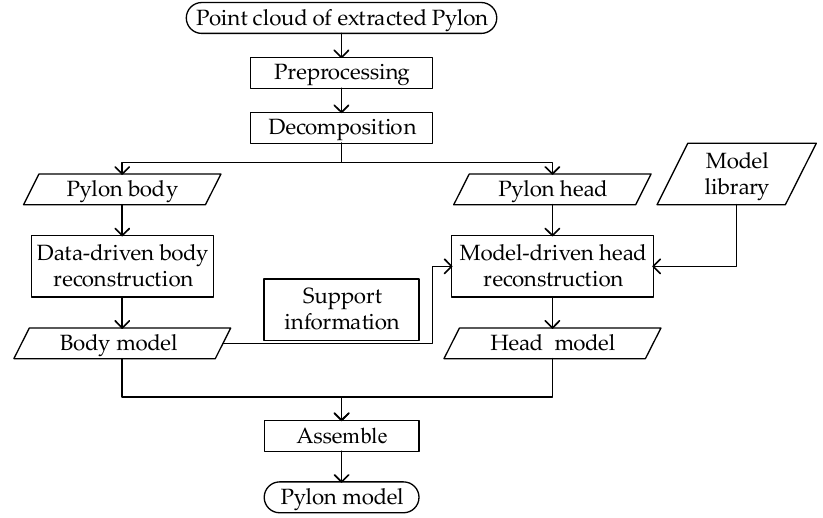
Figure 1. Processing flowchart of the proposed method.